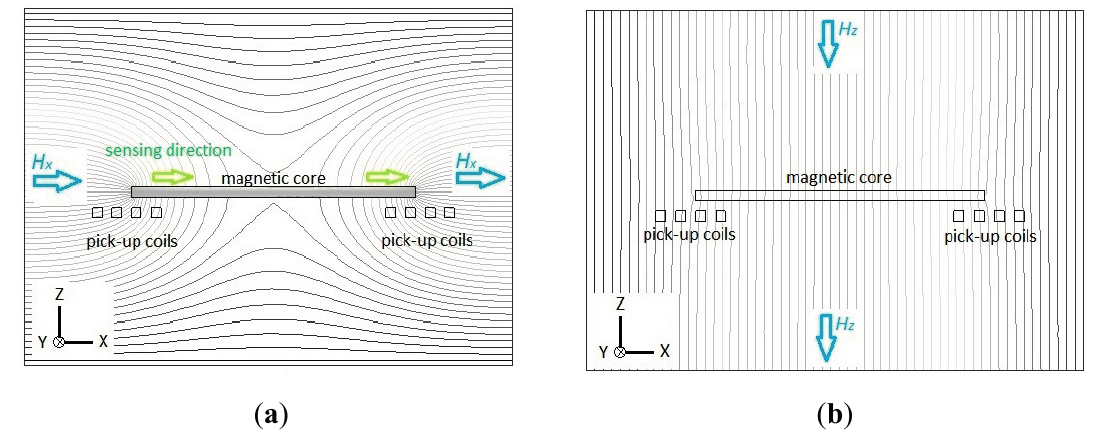
Figure 2. Flux line diagrams illustrate the sensing principle of the planar fluxgate only with a cruciform core and the cross-section is along the longitudinal core: ( a ) in X-axis sensing direction; ( b ) in Z-axis sensing